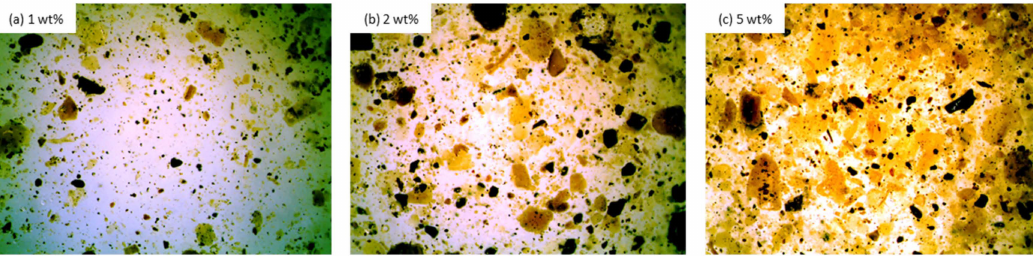
Figure 4. Polyol mixtures containing ( a ) 1 wt%, ( b ) 2 wt%, and ( c ) 5 wt% of clove filler observed at 50 ×